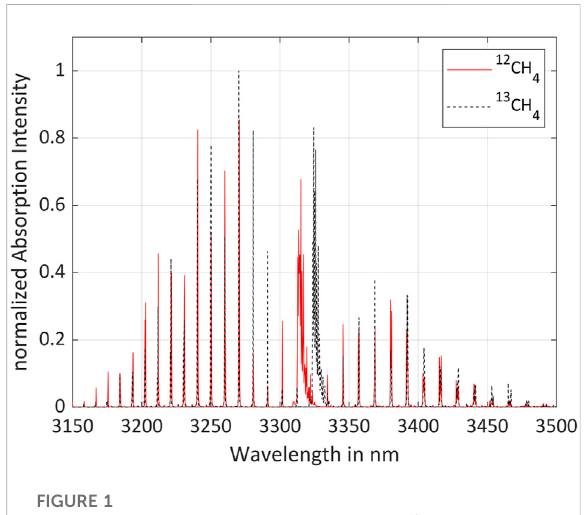
FIGURE 1 Fundamental vibrational absorption spectra of 12 CH 4 and 13 CH 4 (Gordon et al.,